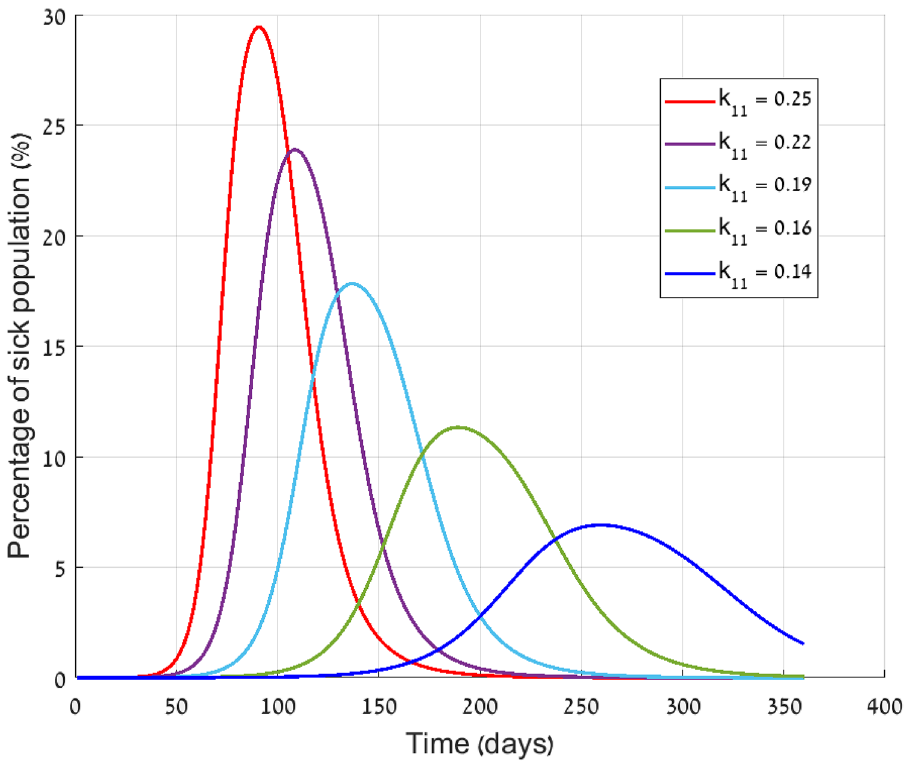
Figure 4. Morbidity for various values of k 11 (DeVisscher